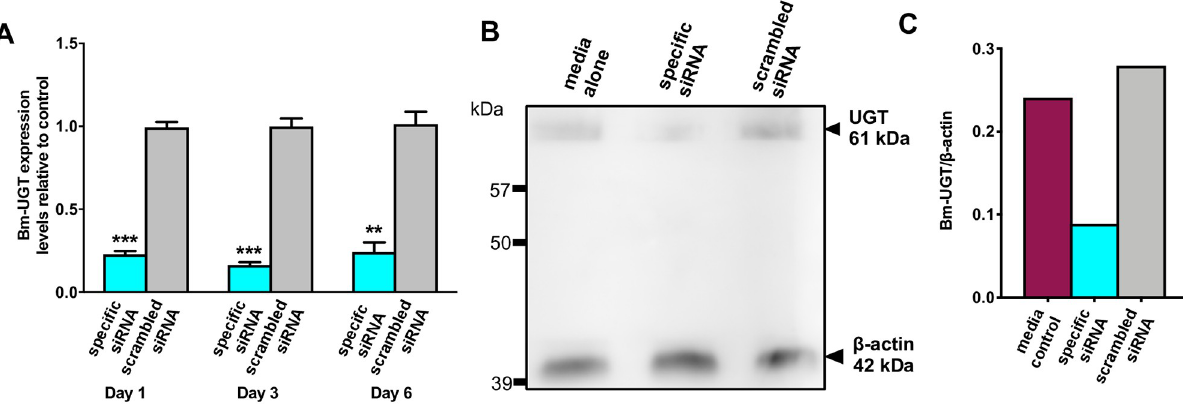
Fig 4. Bm-UGT siRNA incubation reduces target transcript and protein levels in adult B . malayi worms. Adult female worms were incubated with Bm-UGT siRNA, scrambled siRNA, or media alone. (A) Target mRNA levels (n = 3) in the specific siRNA and scrambled siRNA treated groups were measured by RT-qPCR relative to the media control normalized to Bm-gapdh , (Day 1, p = 0.0002; Day 3, p < 0.0001; Day 6, p = 0.0034). p values were generated using an ordinary one-way ANOVA followed by Tukey’s multiple comparison test. These experiments were successfully repeated twice and the data shown is from a single representative experiment; mean ± SEM. (B) Bm-UGT expression (n = 5) was evaluated 24 hrs post-siRNA incubation using anti-Bm-UGT peptide antibodies. (C) Western blot quantification was performed using the ImageStudioLite software. Depicted are the signal intensities of anti-UGT normalized to